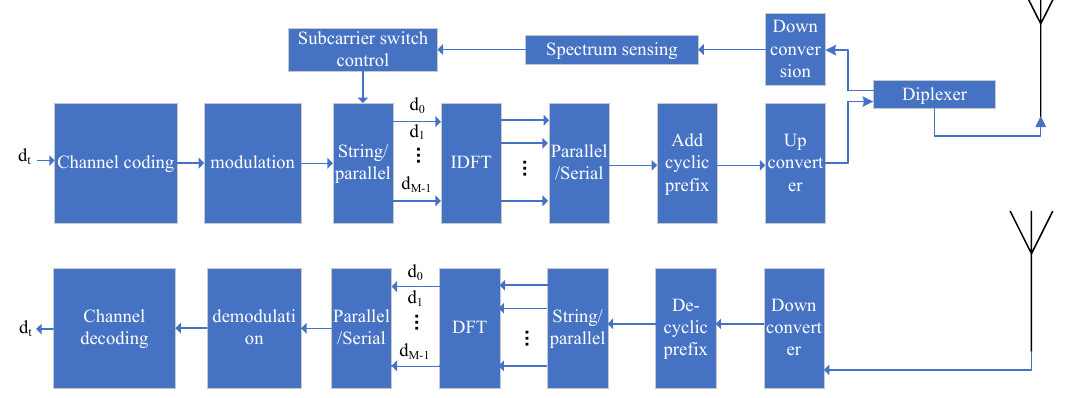
Figure 1. NC-OFDM satellite communication system model based on spectrum